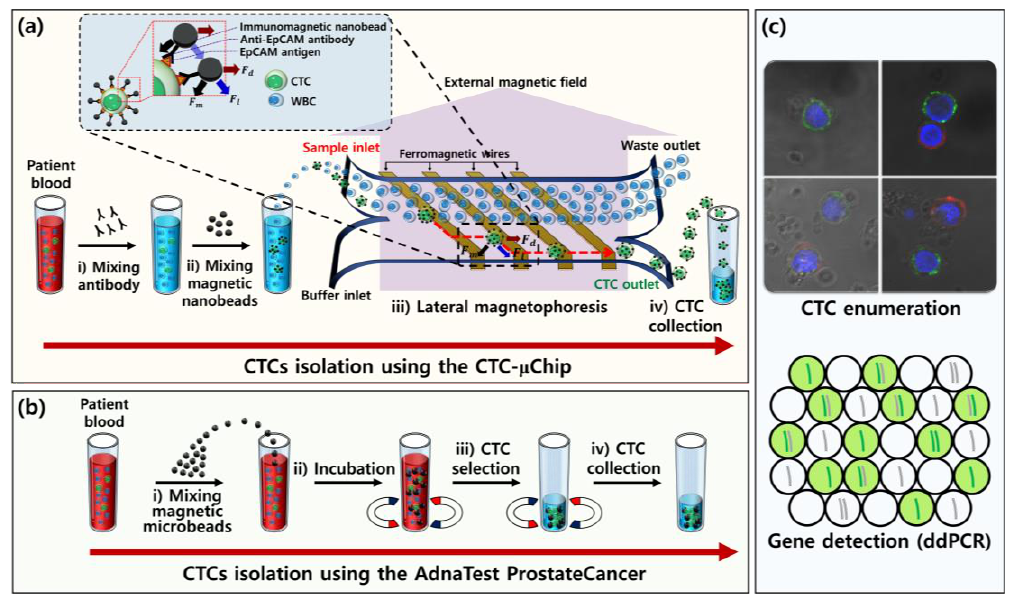
Figure 1. Illustration of the experimental workflows to isolate circulating tumor cells (CTCs) with the CTC-µChip and the AdnaTest ProstateCancer. ( a ) For the CTC-µChip, blood samples were treated with a density gradient centrifugation to remove the red blood cells (RBCs), followed by incubation with (i) anti-EpCAM antibodies and (ii) immunomagnetic nanobeads, in sequence. Then, (iii) the prepared blood sample and phosphate-buffered saline (PBS) were injected into the CTC-µChip, and (iv) the CTCs flowed along the ferromagnetic wires and were isolated at the CTC outlet. ( b ) For the AdnaTest ProstateCancer, (i) whole blood was mixed and (ii) incubated with immunomagnetic microbeads. (iii) The treated blood samples were placed in a magnet to collect the CTCs, and (iv) the supernatant was discarded to enrich the CTCs. ( c ) Downstream analyses were performed to enumerate the CTCs and characterize their gene expression using RT-ddPCR.